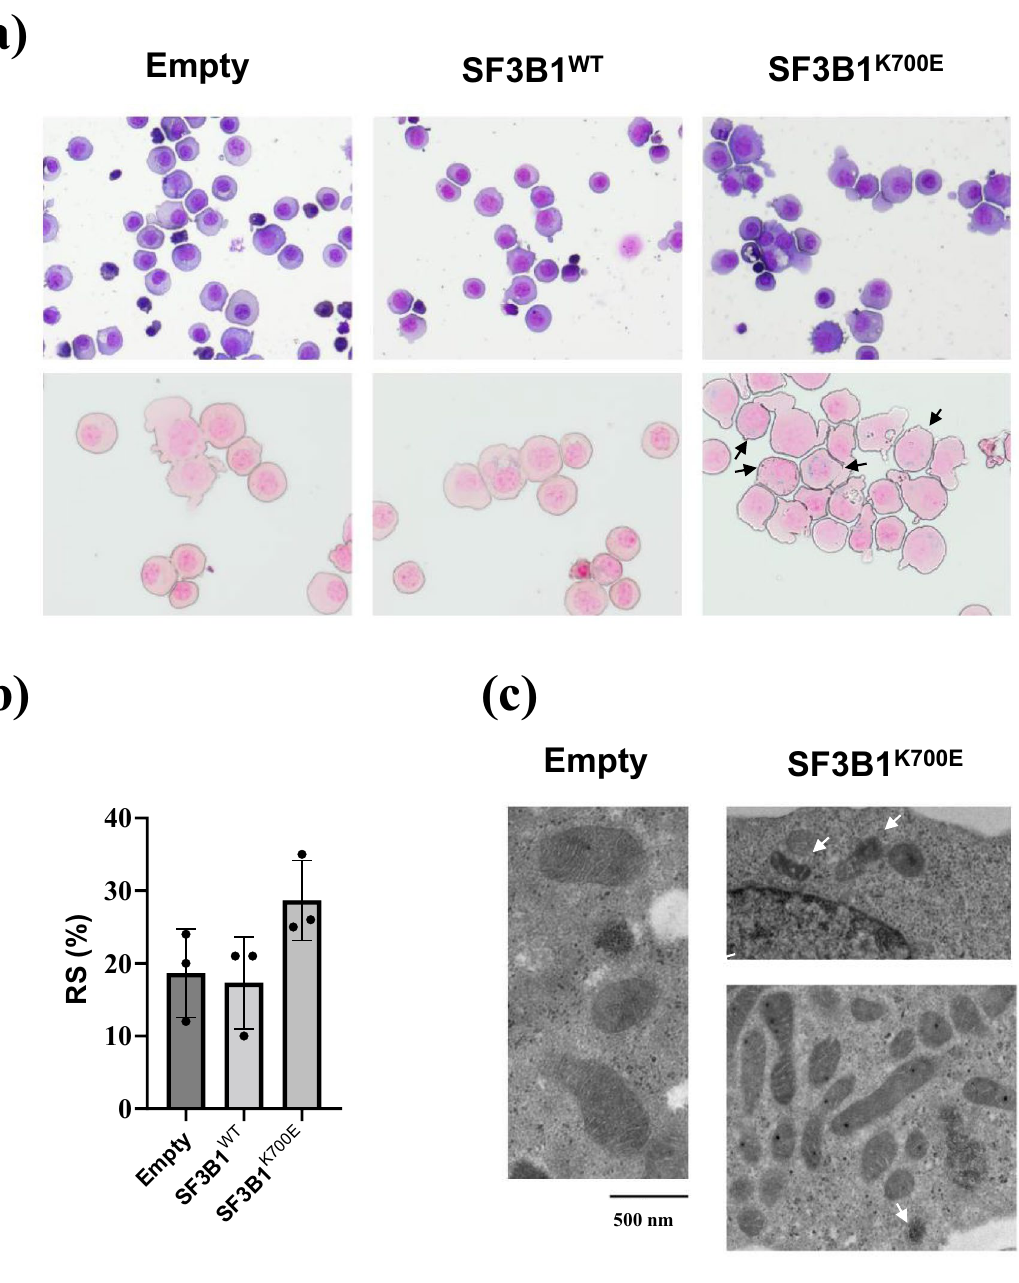
Figure 1. RS formation of HUDEP-2 cells stably expressing SF3B1 K700E after differentiation. ( a ) Representative micrograph of cytospin slides for differentiated HUDEP-2 cells stably expressing SF3B1 K700E or controls. The upper photographs show slides stained with May–Grünwald–Giemsa stain, and the lower ones represent those stained with Prussian blue. Ring sideroblasts are indicated by black arrows. ( b ) RS proportion of differentiated HUDEP-2 cells stably expressing SF3B1 K700E or controls are shown as mean ± SD and dot plots. ( c ) Representative electron micrographs of differentiated HUDEP-2 cells stably expressing SF3B1 K700E or controls. Electron dense deposits in mitochondria are indicated by white